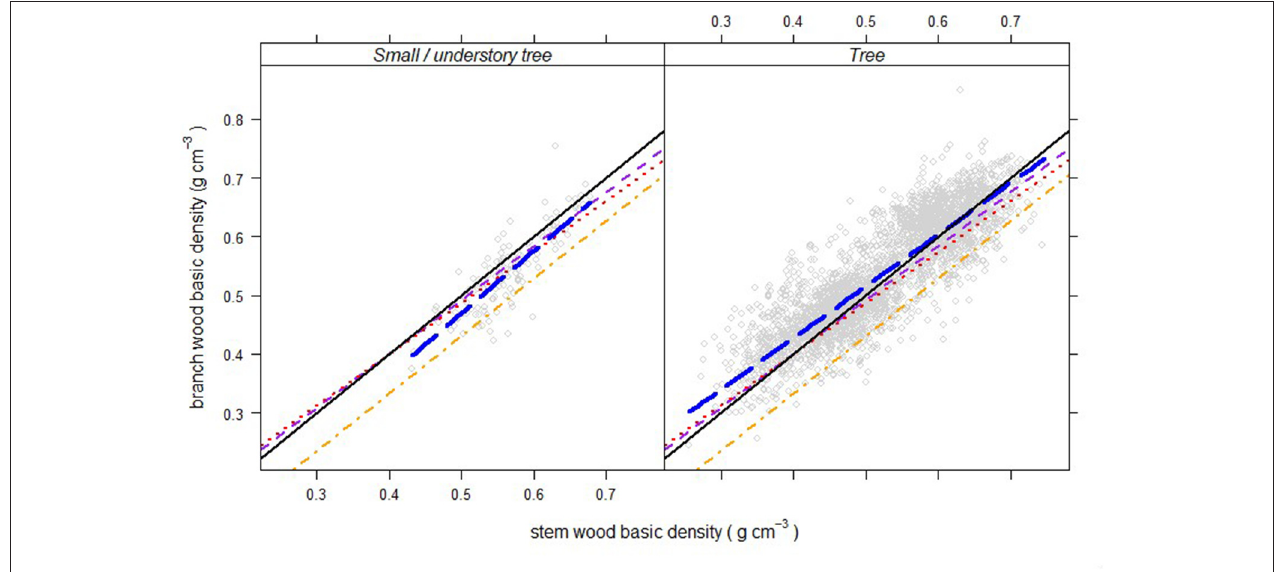
FIGURE 2 | Branch wood – stem wood density relationships (thick, blue, long-dashed lines) for North American trees (gray circles) of two different growth forms. Short-dashed (purple) lines represent the relationship for trees in tropical rainforests in French Guiana published by Sarmiento et al. (2011). Dotted (red) and dot-dashed (orange) lines are relationships for trees and shrubs, respectively, in tropical wet forests in Puerto Rico, reported by Swenson and Enquist (2008).